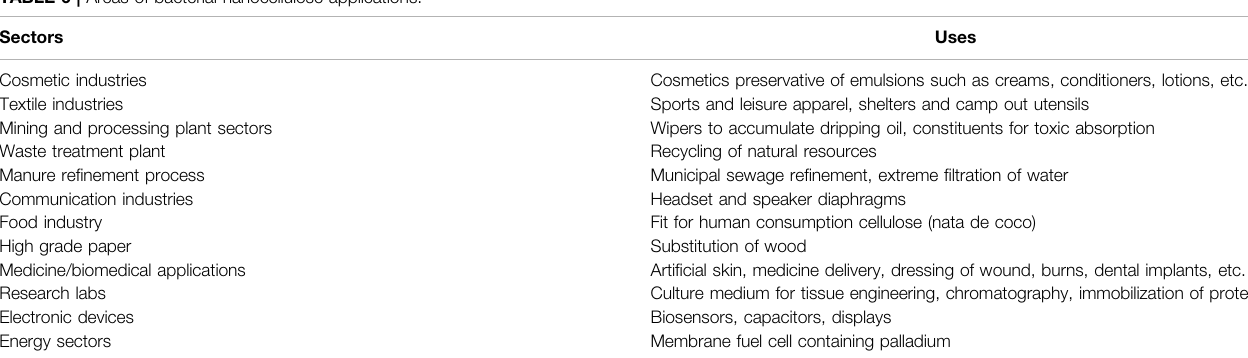
TABLE 6 | Areas of bacterial nanocellulose applications. Sectors Cosmetic